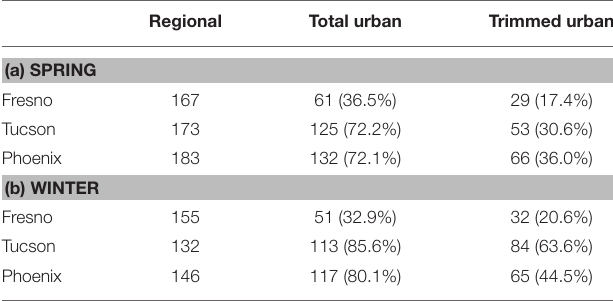
TABLE 1 | Species richness for regional species pools and urban assemblages for spring (a) and Winter